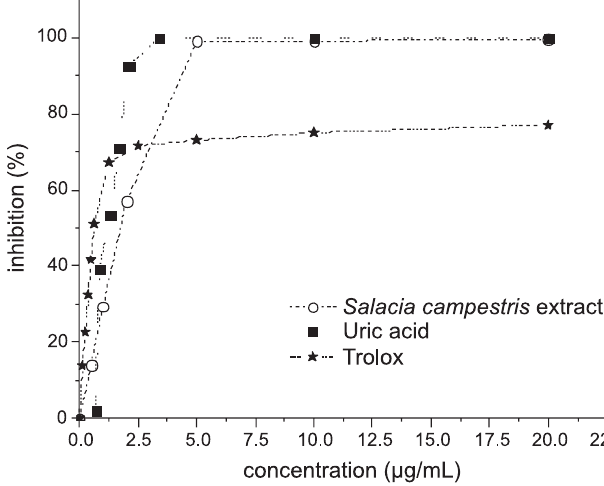
FIGURE 2 - ABTS •+ radical (55 µM) Scavenger action by S. campestris extract, uric acid and trolox. The reactions were made in 10mM sodium phosphate buffer, pH 7.0, 25 0 C, and incubated by 30 min.